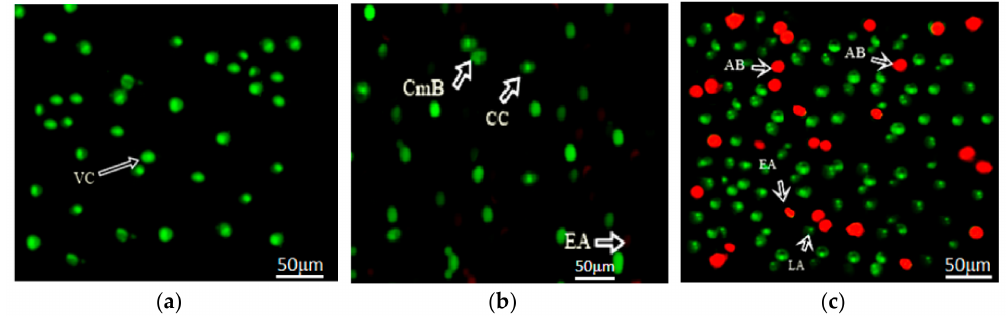
Figure 11. Fluorescent micrographs of (acridine orange/propidium iodide) AO/PI double stained MCF-7 cells that were treated with GO-ZnO nanocomposites (400 × magnification). ( a ) untreated cells presenting normal cell structures; ( b ) treated MCF-7 cells after 12 h incubation; ( c ) MCF-7 cells after